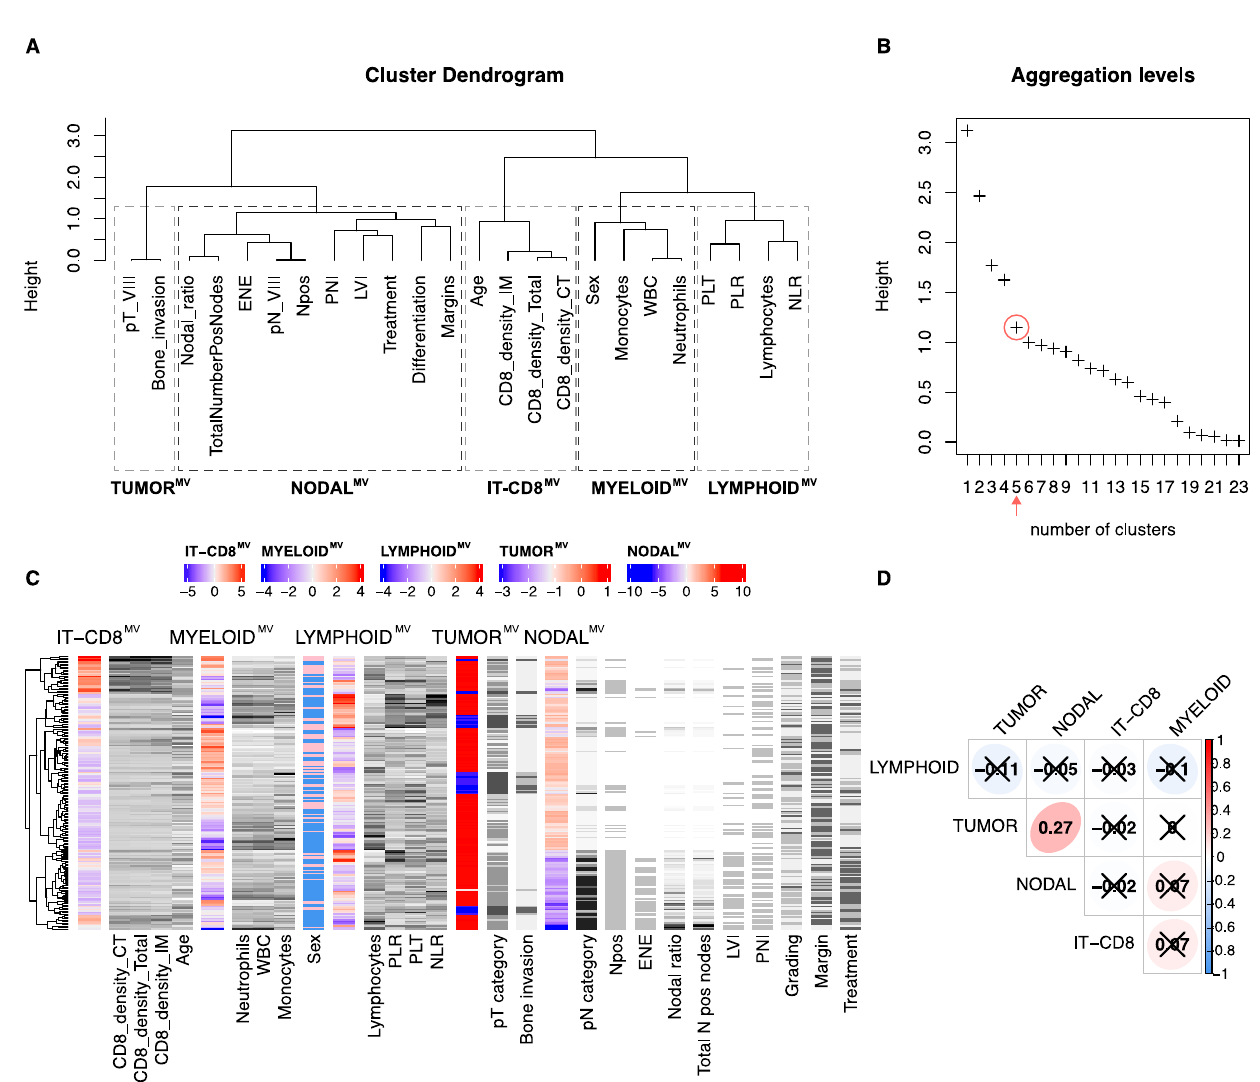
Figure 2. Dendrogram of the hierarchical ascending clustering of the 24 demographic, clinical, pathological and peripheral and tissue biomarkers according to their correlation ratio ( A ); aggregation level plot related to the number of clusters of variables, red circle showing the chosen 5 clusters as optimum choice ( B ); heatmap showing the relationship between each metavariable (MV) and the original variables from which is derived (columns on the right of each metavariable) ( C ); and correlogram showing the Spearman correlation between each metavariable, R coefficient is shown, adjusted not significant comparisons are covered with a cross ( D ). Dashed rectangles in A highlight which original variable is included in each MV.